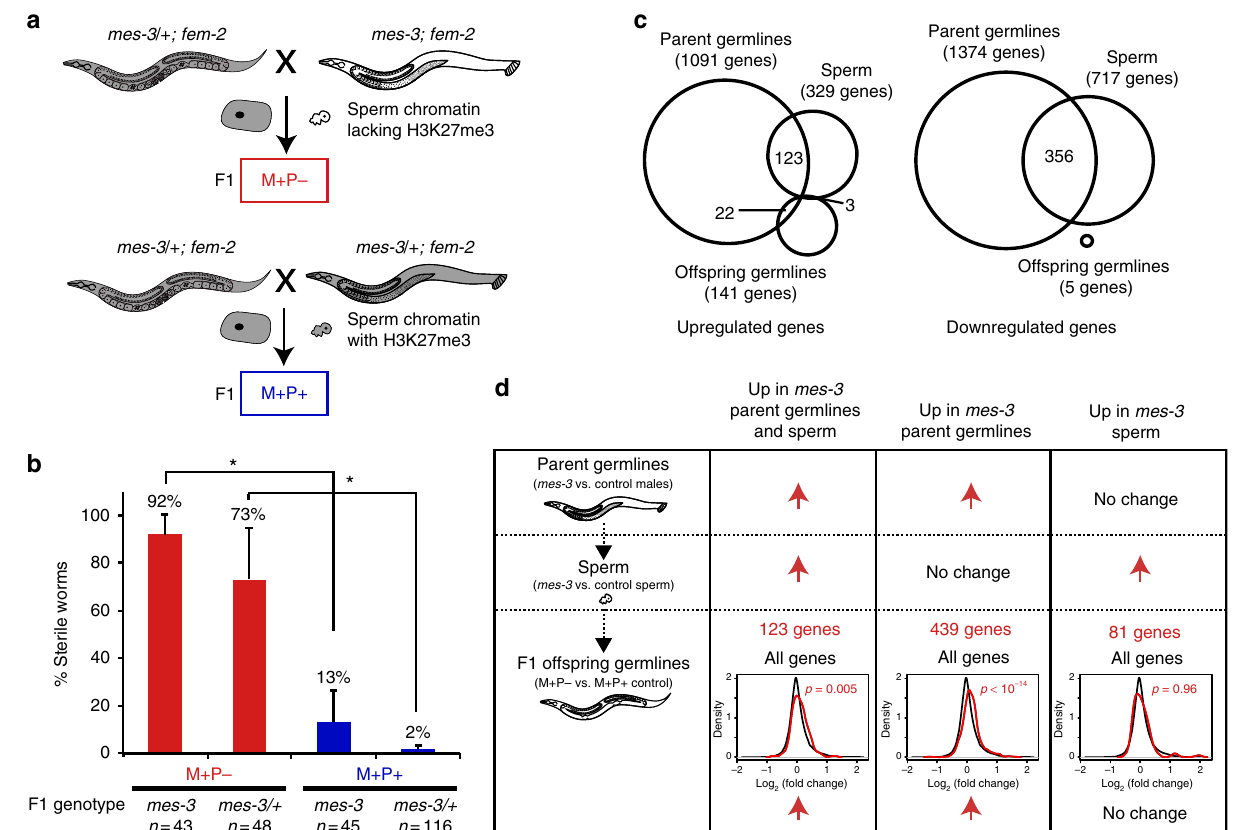
Fig. 4 The sperm epigenome is important for germline development in offspring. a Genetic strategy to test if sperm chromatin marking is necessary for germ cell development in offspring that inherit both sperm and oocyte chromosomes, using male parents that either can or cannot generate H3K27me3. b Histogram showing % sterile hermaphrodites among the F1 offspring that received sperm chromosomes lacking H3K27me3 (red, M + P − for Maternally marked chromosomes, Paternal chromosomes lacking the mark) vs. properly marked sperm chromosomes (blue, M + P + ). Error bars show SD of 3 experiments. * Statistically signi fi cant differences between the genetically identical M + P − vs. M + P + offspring, one-tailed Student ’ s t -test, p ≤ 0.01. c RNA-seq analysis of germlines from male parents, mature sperm, and the germlines of F1 offspring. Venn diagrams show genes signi fi cantly up- or downregulated in mes-3 male germlines (3 biological replicates) compared with control male germlines (4 biological replicates), mes-3 sperm compared with control sperm (3 biological replicates each), and F1 M + P − germlines compared with genetically identical F1 M + P + germlines (2